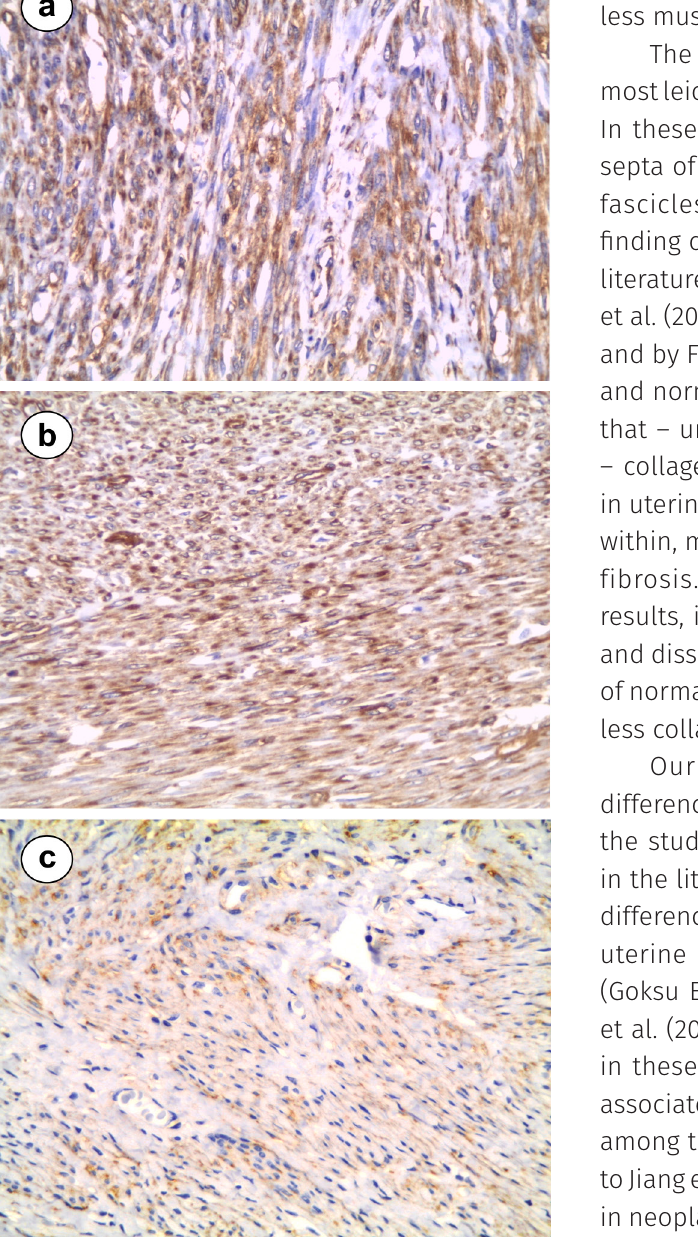
Figure 2. Immunoexpression of Cripto-1 in the lesions. (a) Intense and diffuse immunoexpression of Cripto-1 in oral leiomyoma (400x). (b) Intense and diffuse immunoexpression of Cripto-1 in uterine leiomyoma (400x). (c) Mild and diffuse Cripto-1 immunoexpression in normal myometrium